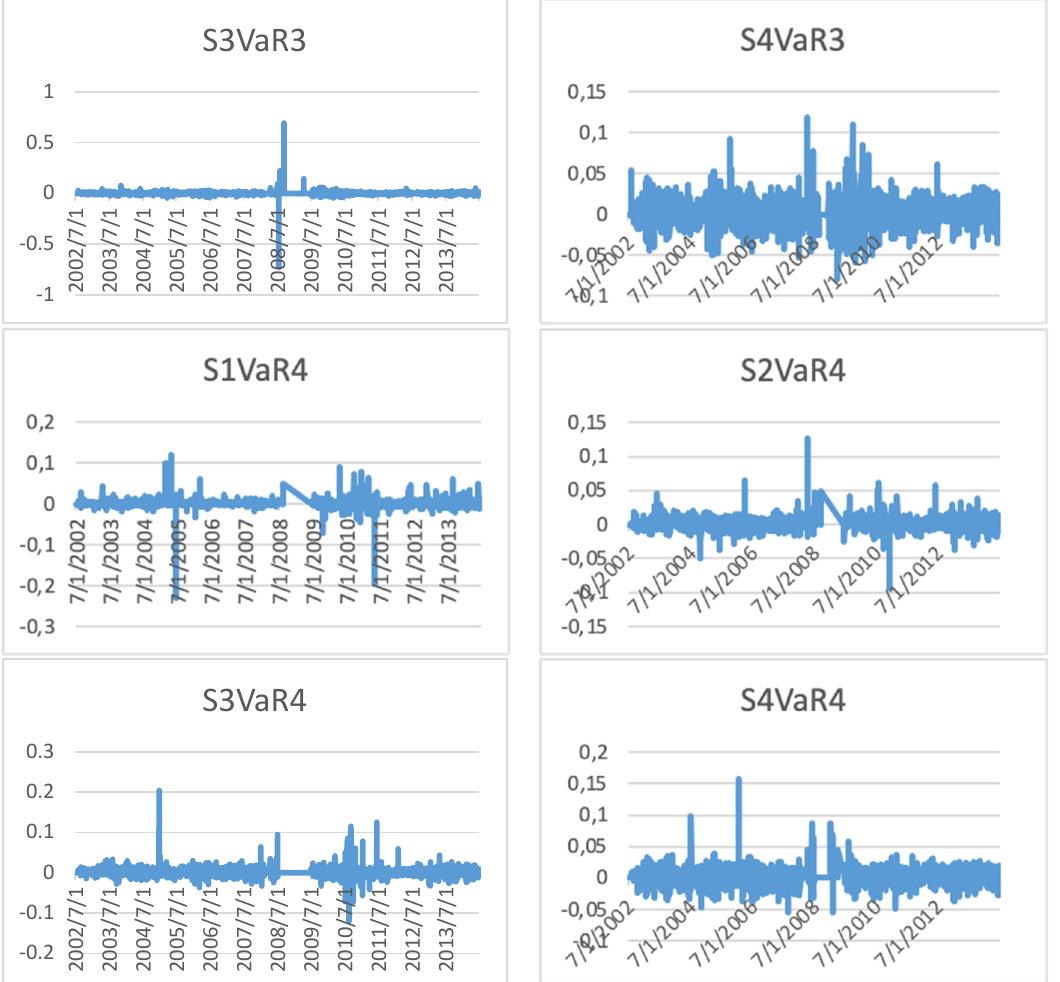
Figure A4. Daily Portfolios’ Returns of Size(S) and VaR (99% Level of Confidence).